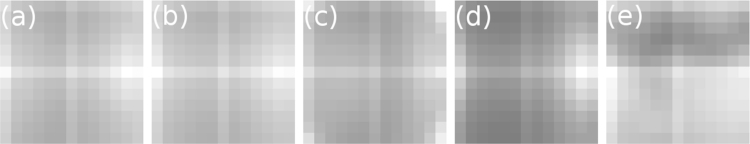
Distributions of centroided photon positions within a pixel for the USAF test pattern data set. (a) ML with Gaussian PSF and 2-pixel fitting radius, and 7-pixel fitting radius (b) without and (c) with MFA; (d) weighted LS with Integrated Gaussian PSF; and (e) radial symmetry.